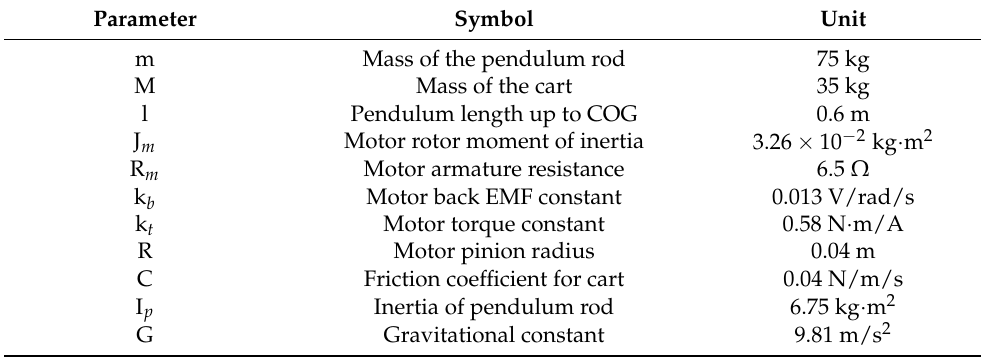
Table 3. Nominal values of model